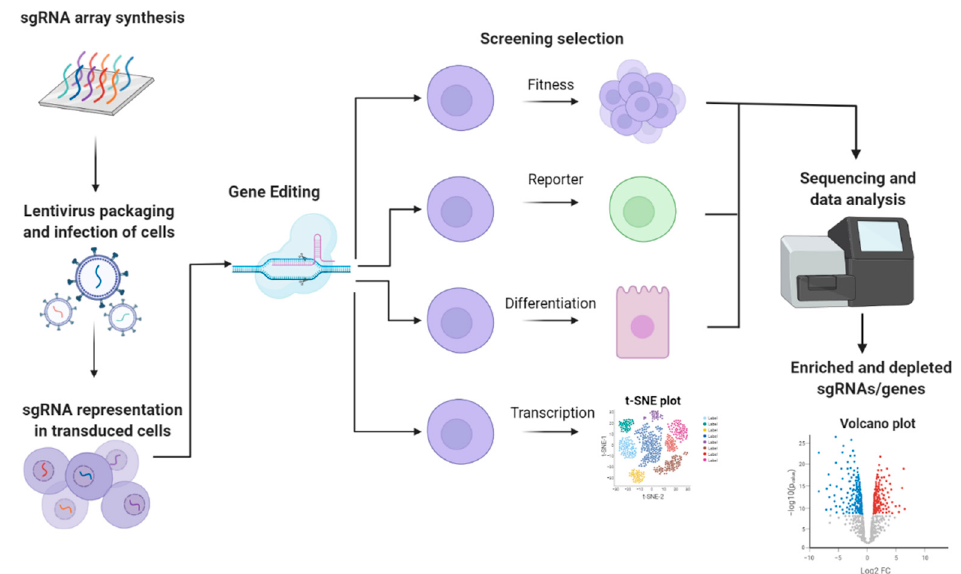
Figure 2. The general approach for high-throughput reverse genetics screening. (Created with BioRender.com (accessed on 12 December 2021)).